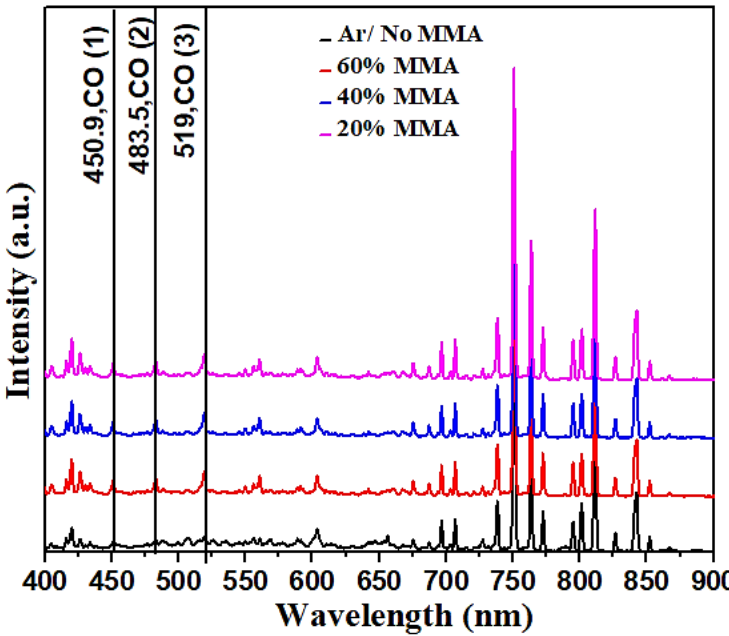
Figure 7. Optical emission spectra with the change in monomer concentration.